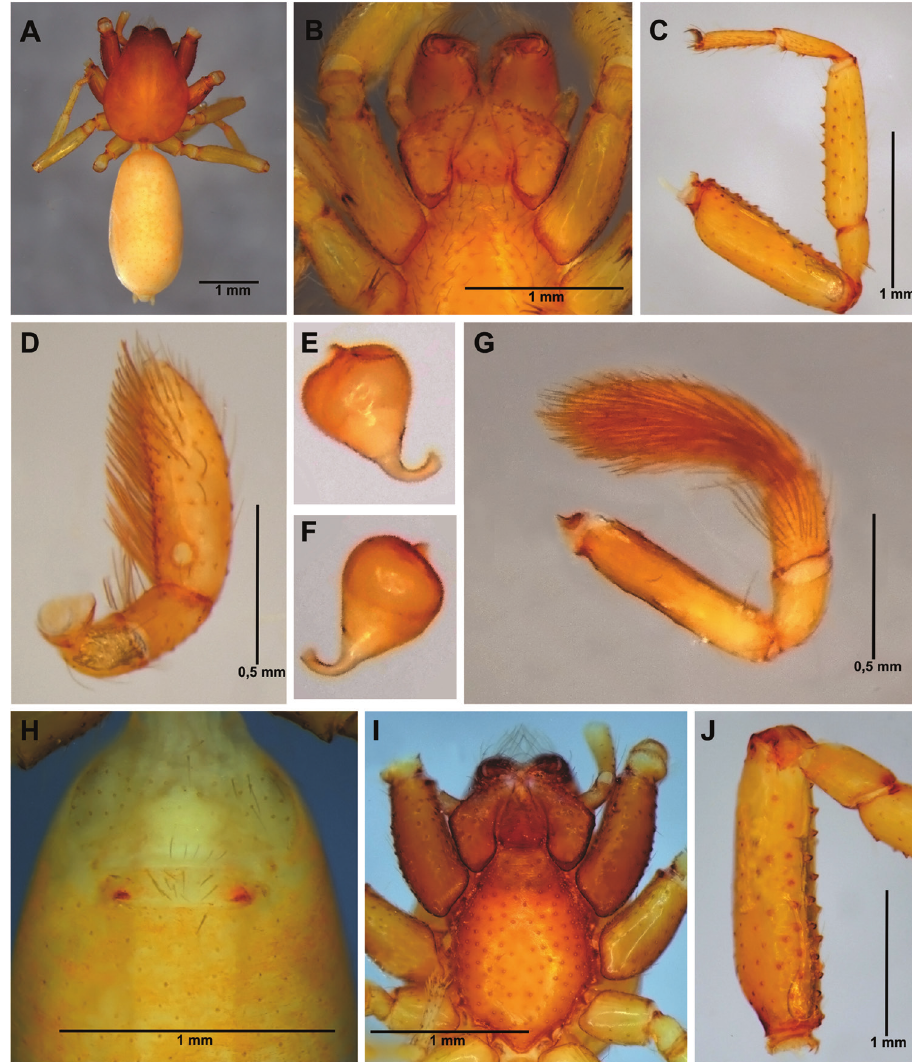
Figure 1. Tisentnops mineiro sp. n. , male holotype ( A–G, J ), female paratype, IBSP 191294 ( H–I ). A habitus, dorsal view B mouthparts, ventral view C leg I, prolateral view D left male palp, ventral view, showing alveolus (bulb removed) E male bulb, prolateral view F same, retrolateral view G left male palp, prolateral view (bulb removed) H female external genitalia, ventral view I carapace, ventral view J male femur I, retrolateral